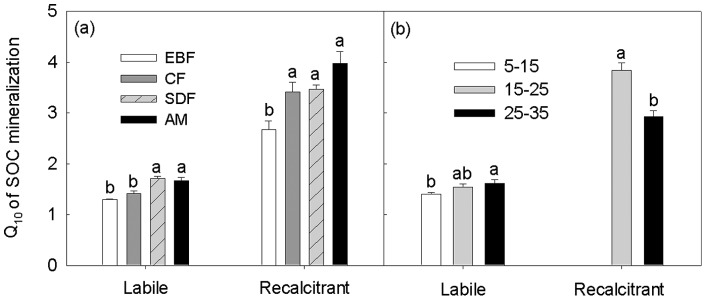
The temperature sensitivity of SOC mineralization for both the labile and the recalcitrant SOC mineralization along the elevation in the four vegetations (a) and at different incubation temperature intervals (b).Values are Mean±SE. Different letters stand for significant difference at P<0.05. Asterisks indicate the statistical difference at P<0.01. Missing value in Figure 2C at 5–15°C is because some soils incubated at 5°C did not respire 9% of the total C during the incubation period. LOC: the SOC can be easily decomposed by microorganisms, resulting from the fresh residues such as plant roots and living microbes; ROC: the SOC that is resistant to decay, such as cellulose, humus, and tannin.